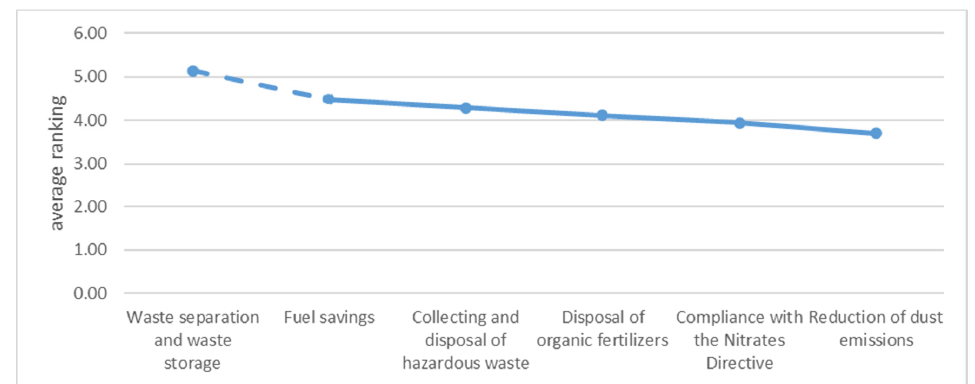
Figure 6. Results of the Wilcoxon test: Perception of the importance of green logistics activities. (Source: own research).